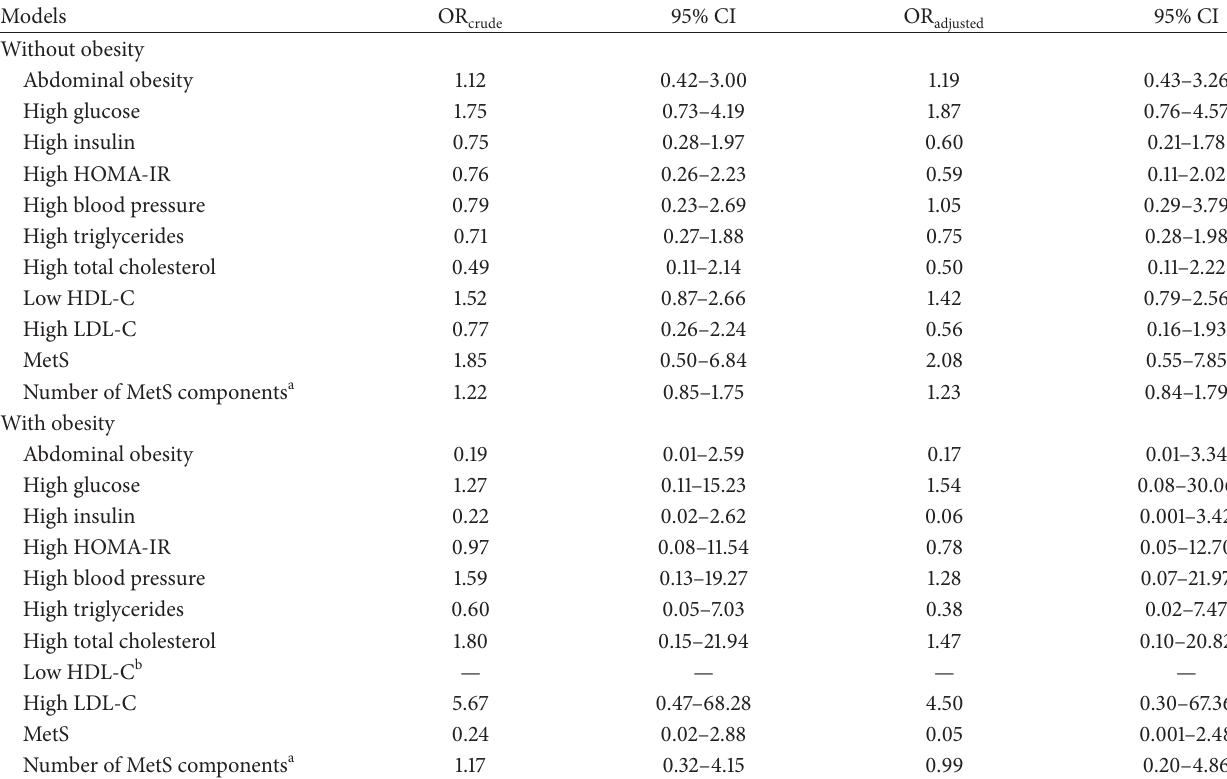
Table 4: Associations between elevated urine albumin concentration and metabolic syndrome or metabolic markers, stratified according to